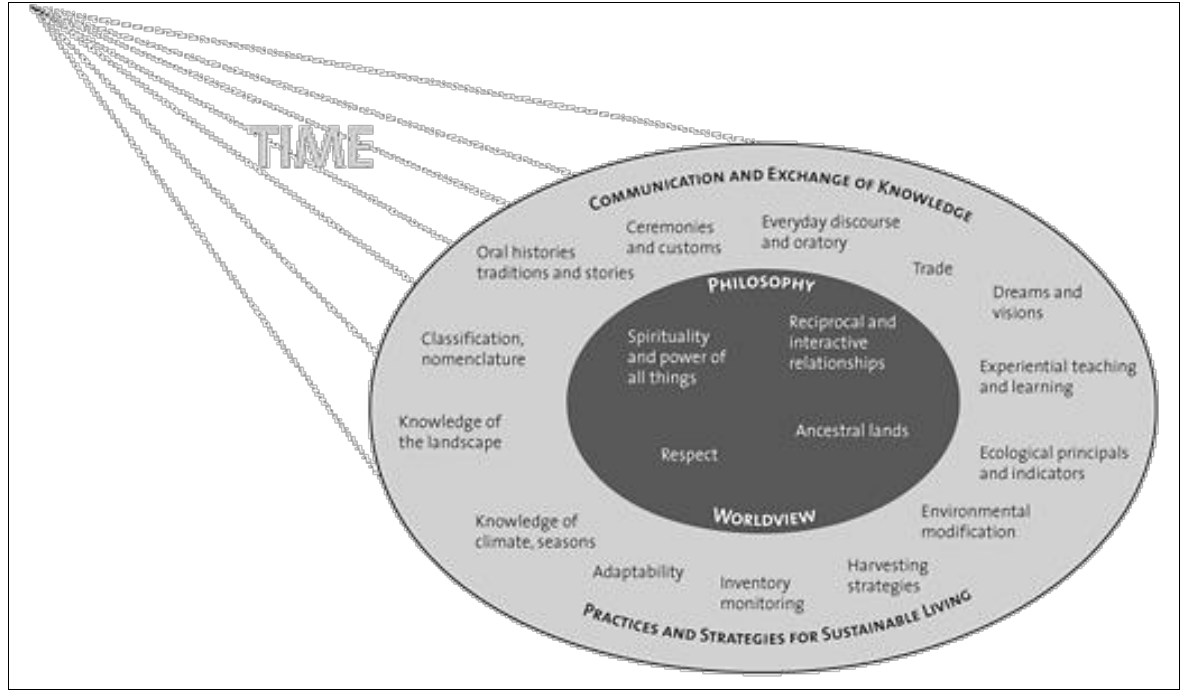
Figure C1. Framework for Traditional Ecological Knowledge and Wisdom of Native